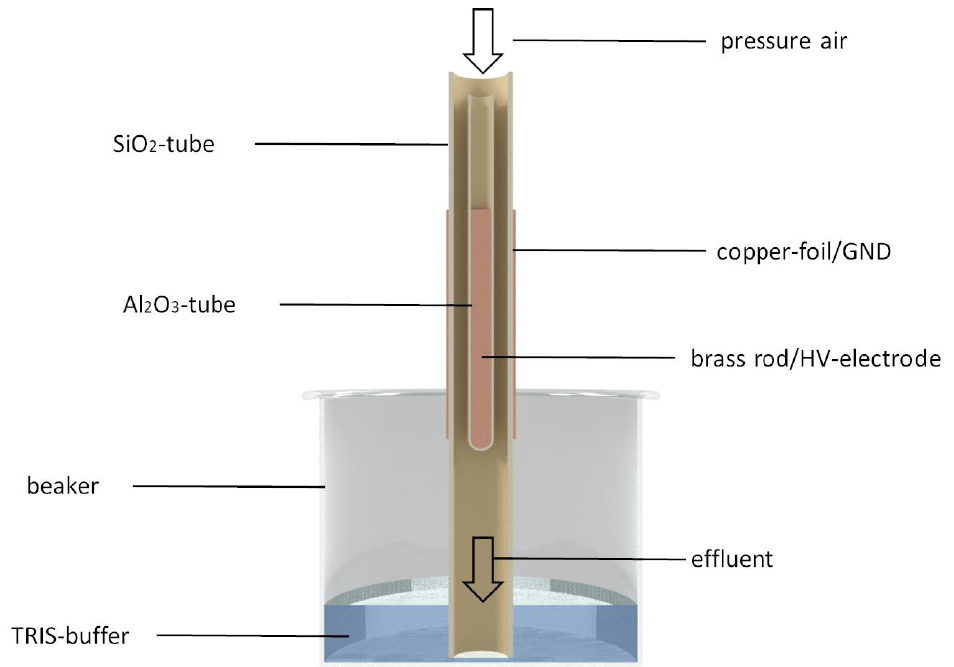
Figure 1. Scheme of a single plasma tube to generate Tb-PAW.